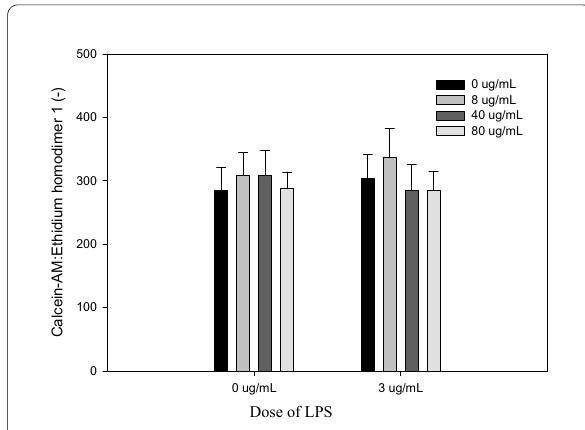
Figure 5 Viability of cells within cartilage explants stimulated with LPS [0 or 3 μg/mL] . Explants were conditioned with HRAM sim [0, 8, 40, or 80 μg/mL] for 96 h, and were stimulated with LPS [0 or 3 μg/ mL] for the final 48 h. Data shown are from the end of the 48 hour stim- ulation period.